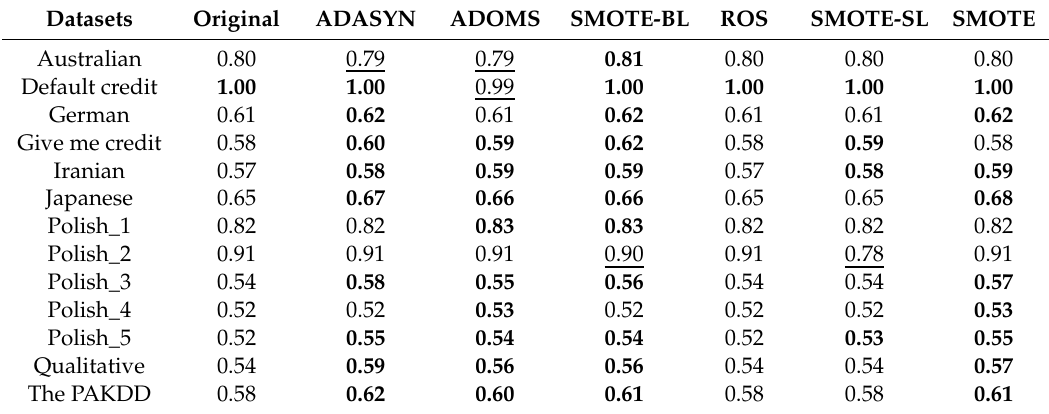
Table 18. AUC for SNDAM classifier after oversampling algorithms.